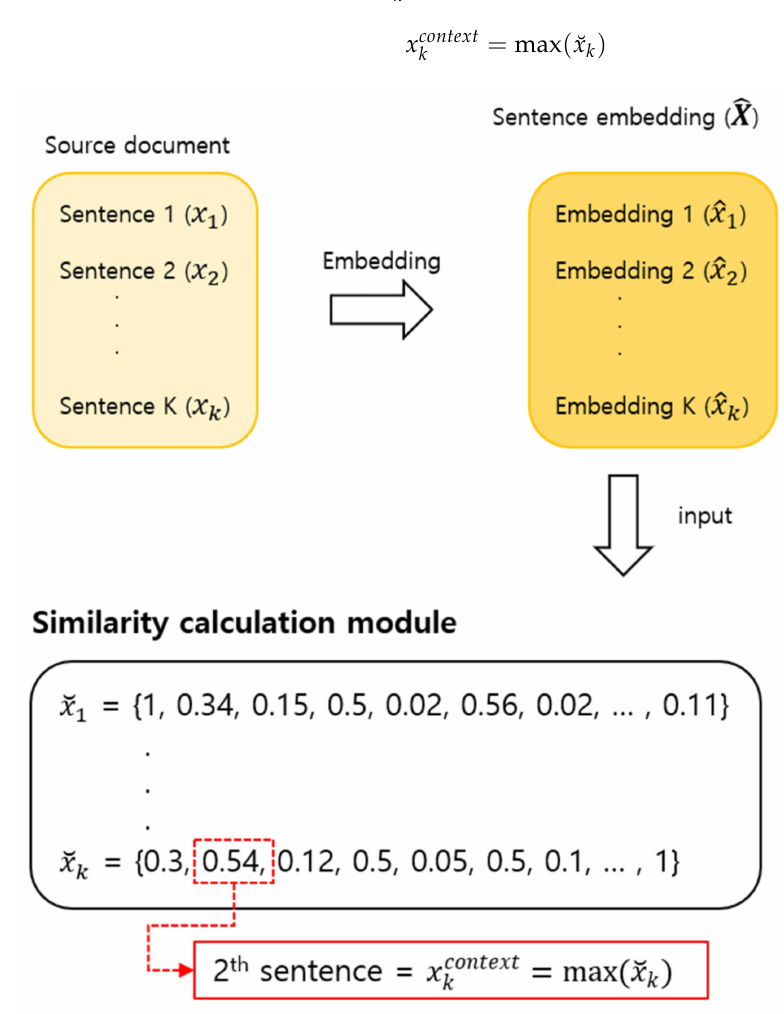
Figure 1. Process of finding the context sentence using the similarity